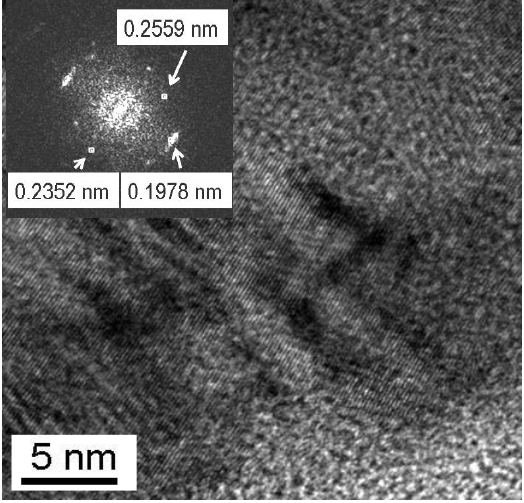
Figure 10. HRTEM image and FFT (inset) of the (Cu+Fe) + Al alloy particle.